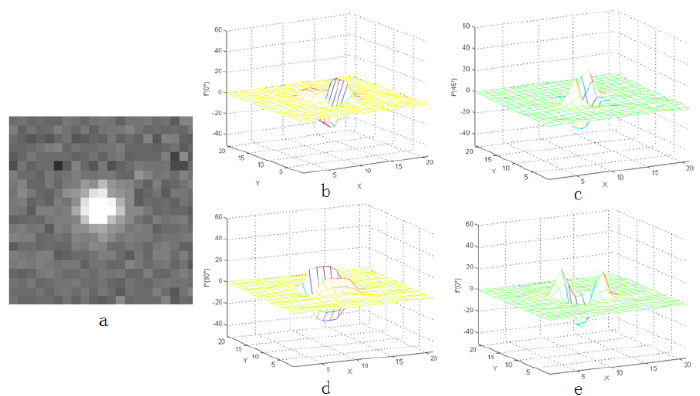
Figure 3. Second-order derivative characteristics of star in four directions: ( a ) the star point and ( b – e ) the three-dimensional distribution of the star point.